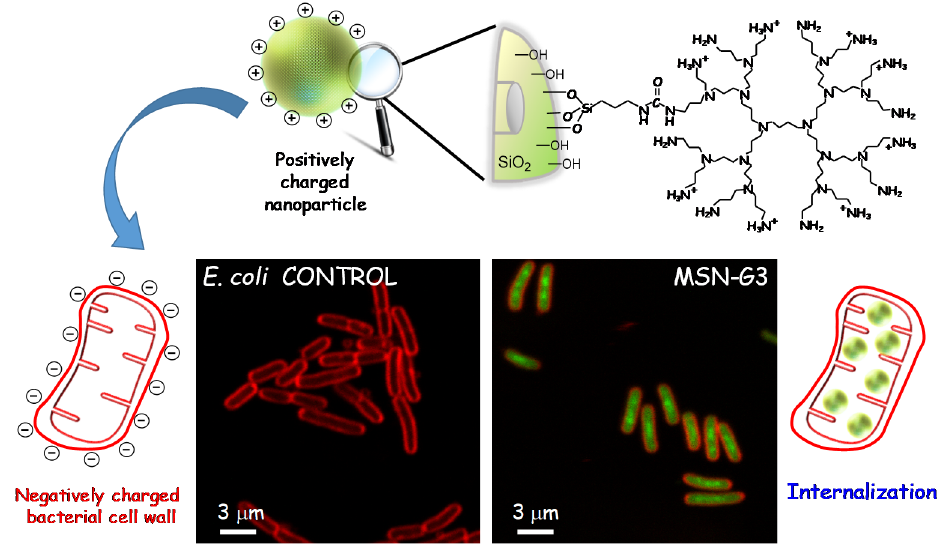
Figure 7. Schematic illustration showing MSNs nanosystem externally decorated with the poly(propyleneimine) dendrimer of third generation (G3) via covalent functionalization and its interaction with Gram-negative E. coli bacteria. The attractive forces between positive charges of the dendrimer on the surface of MSNs and negative charges on bacterial cell wall prompt cell membrane disruption and internalization of the nanosystem. Confocal microscopy images show E. coli control culture (left) and bacteria after exposure to 10 μ g/mL of the MSN-G3 nanosystem during an incubation time of 90 min (right). The E. coli cell membrane was stained in red and the MSN materials have previously been fluorescently tagged in green. Adapted with permission from González et al. [55], Acta Biomater., published by Elsevier, 2018.